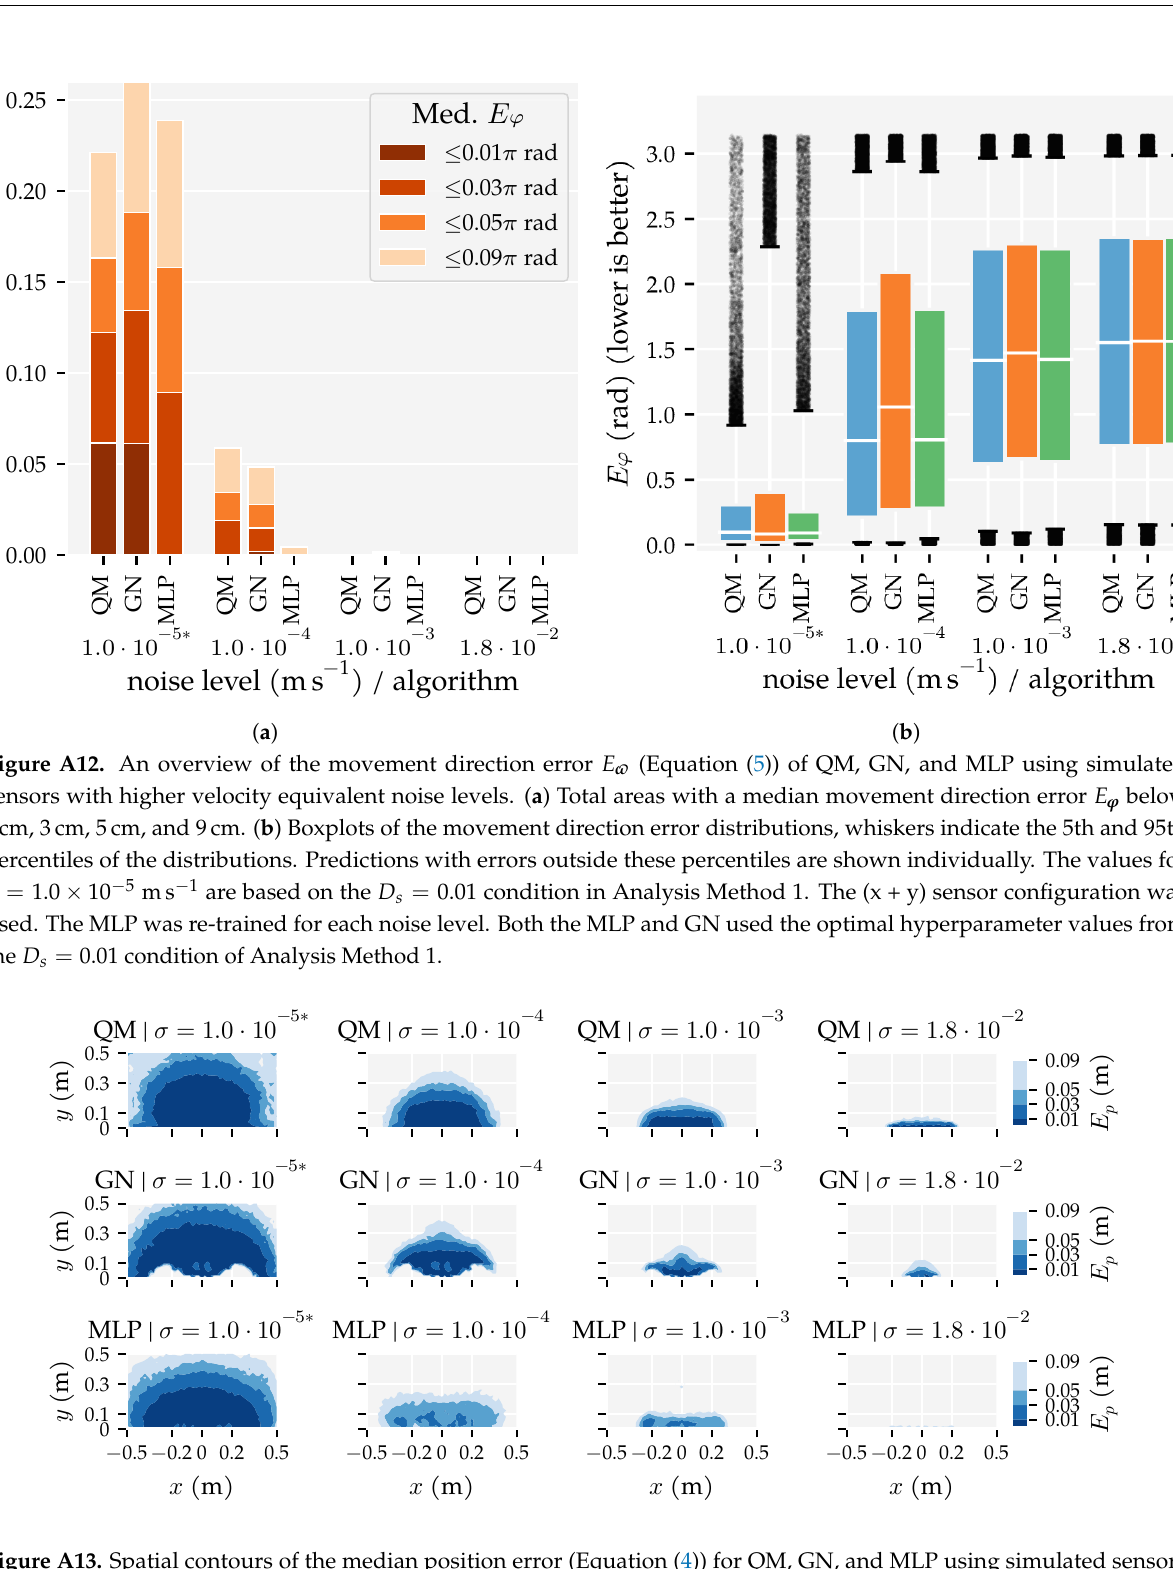
Figure A13. Spatial contours of the median position error (Equation (4)) for QM, GN, and MLP using simulated sensors with higher velocity equivalent noise levels. The D s = 0.01 training and optimisation set and (x + y) sensor configuration were used. The values for σ = 1.0 × 10 − 5 ms − 1 are based on the D s = 0.01 condition in Analysis Method 1. The MLP was re-trained for each noise level. Both the MLP and GN used the optimal hyperparameter values from the D s = 0.01 condition of Analysis Method 1. The median position error was computed in 2 × 2 cm 2 cells. The sensors were equidistantly placed between x = ± 0.2